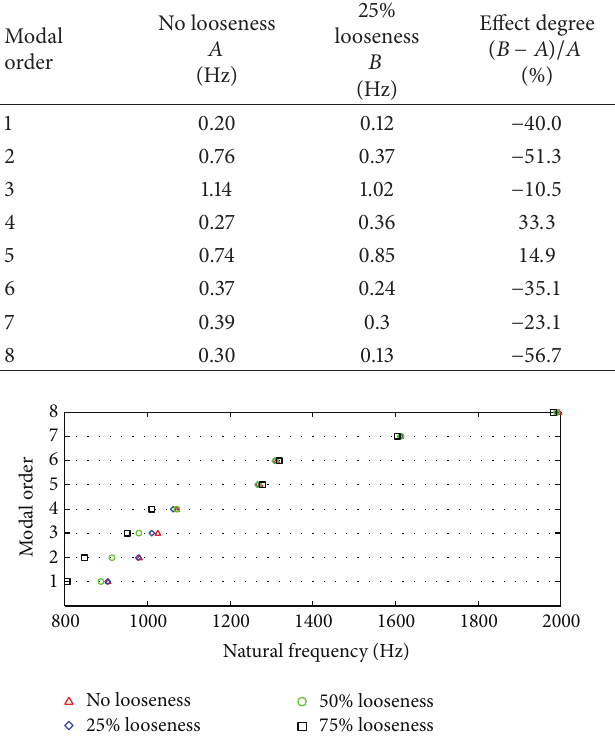
Figure 15: Scattergram of damping ratios of TCS under BLB with different looseness